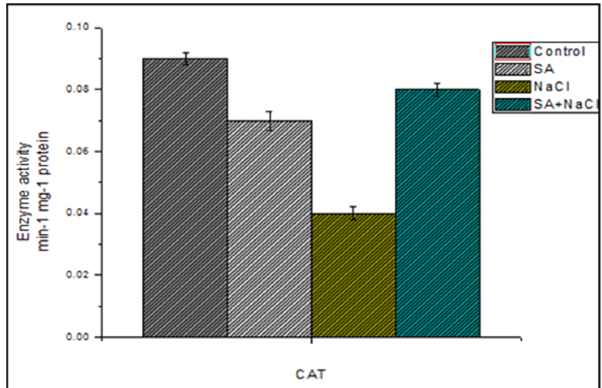
Figure 9. Catalase activity: individual and combined effect of salinity and SA on catalase activity. X axis - treatment group; Y axis - enzyme activity (min -1 mg -1 protein) Values are expressed as mean ± SD, n=3 in each